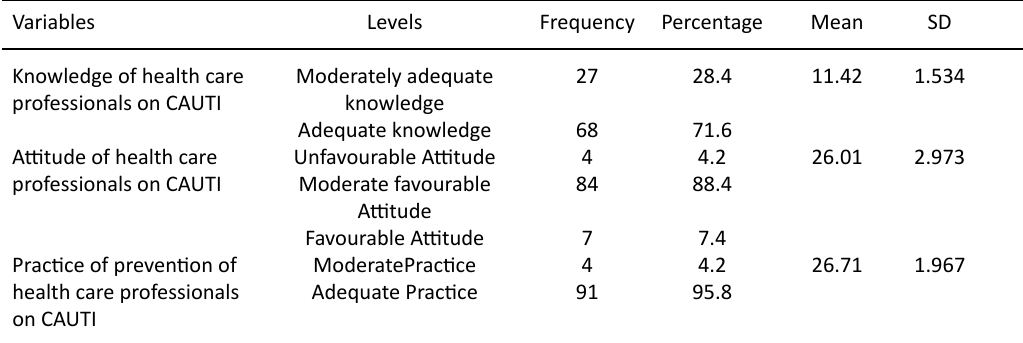
Table 2. Level of Knowledge, Attitude, and Practice on prevention of CAUTI among health care professionals. (n=95) Variables Levels Frequency